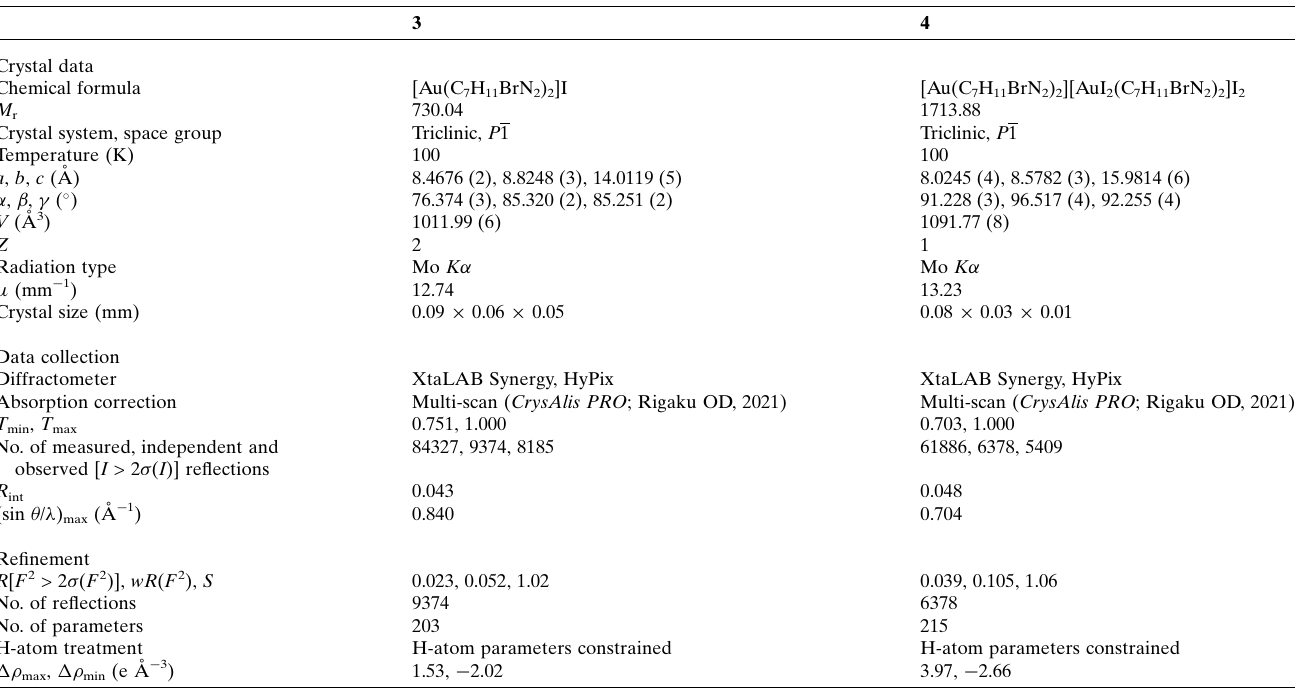
Table 3 Experimental details.